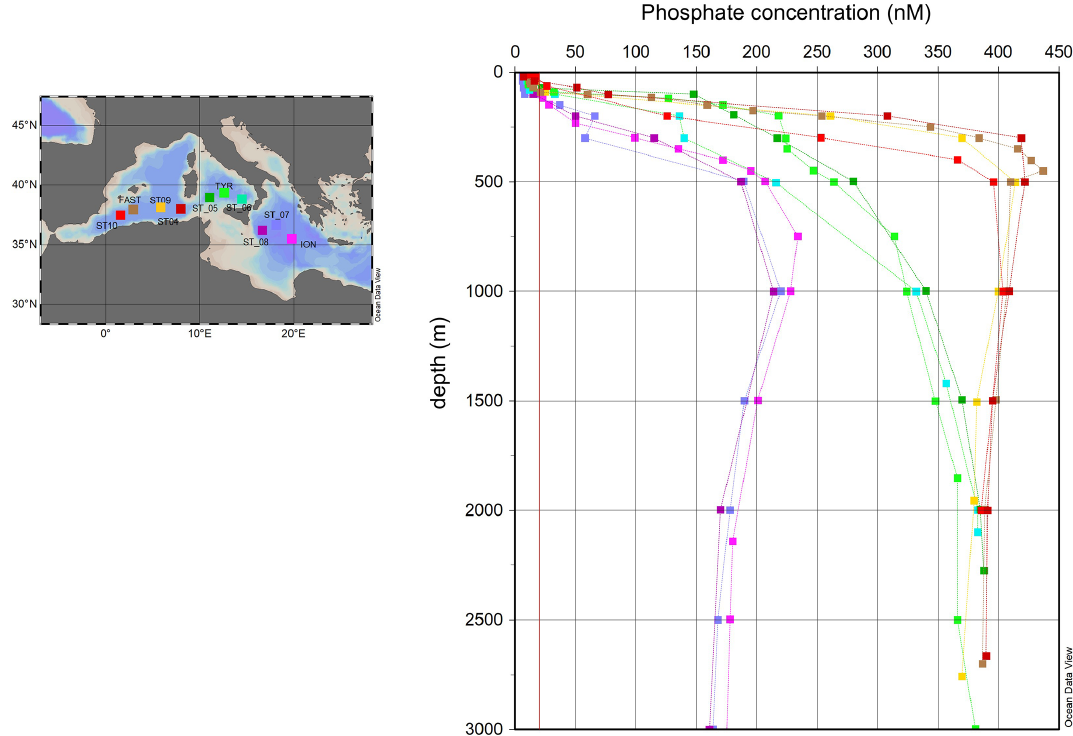
Figure 1. Station location map and depth profiles of phosphate concentration (nM) between the surface and the bottom in the stations located in the Algerian basin (between 0 and 9 ◦ E), in the Tyrrhenian basin (between 10 and 15 ◦ E) and in the Ionian basin (beyond 15 ◦ E) (Schlitzer, R., Ocean Data View, https://odv.awi.de/, last access: 6 September 2021, 2021). As described in Sect. 2 (Material and methods), phosphate vertical profiles were built up from two datasets: one with phosphate concentration obtained through standard technique, with a limit of quantification of 0.02µM (red line), and another one with phosphate concentration below 0.02µM, obtained through the nanomolar LWCC